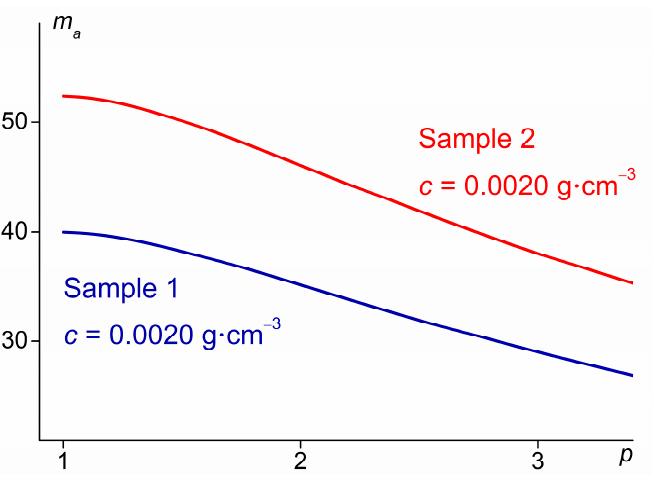
Figure 6. The dependences of aggregation degree m a on asymmetry factor p of modeling ellipsoid for aqueous solutions of PDMS- g -PiPrOx.